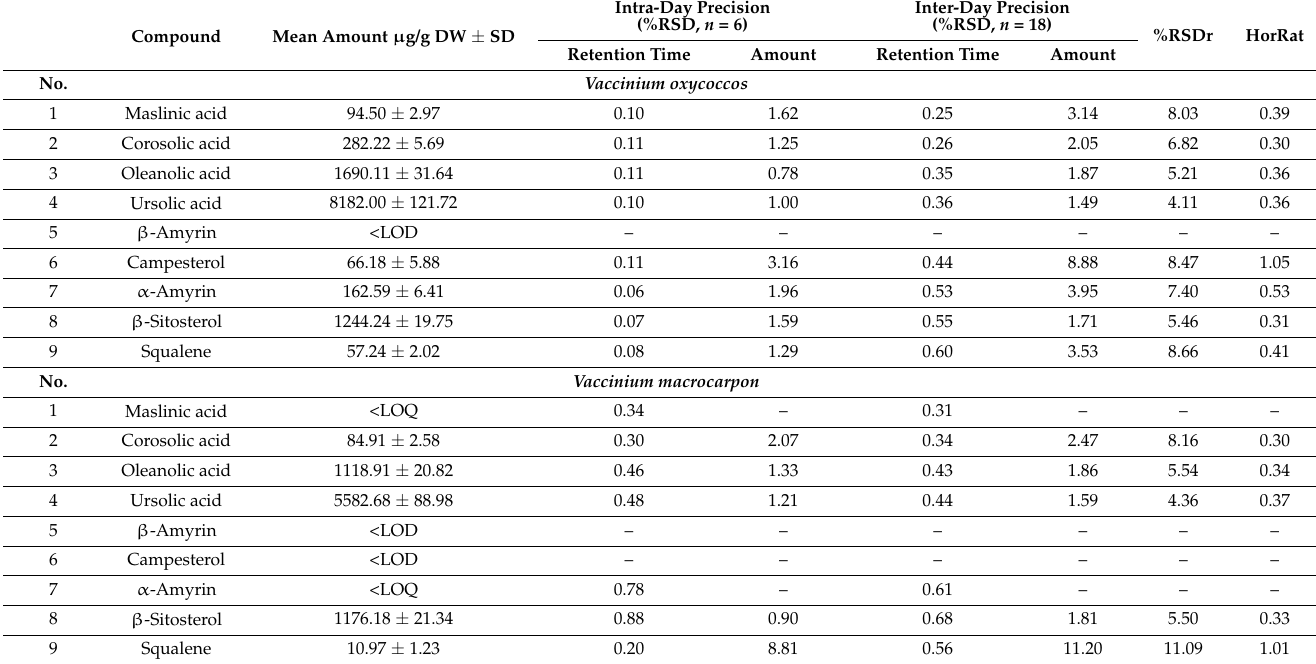
Table 3. Determination of precision in cranberry